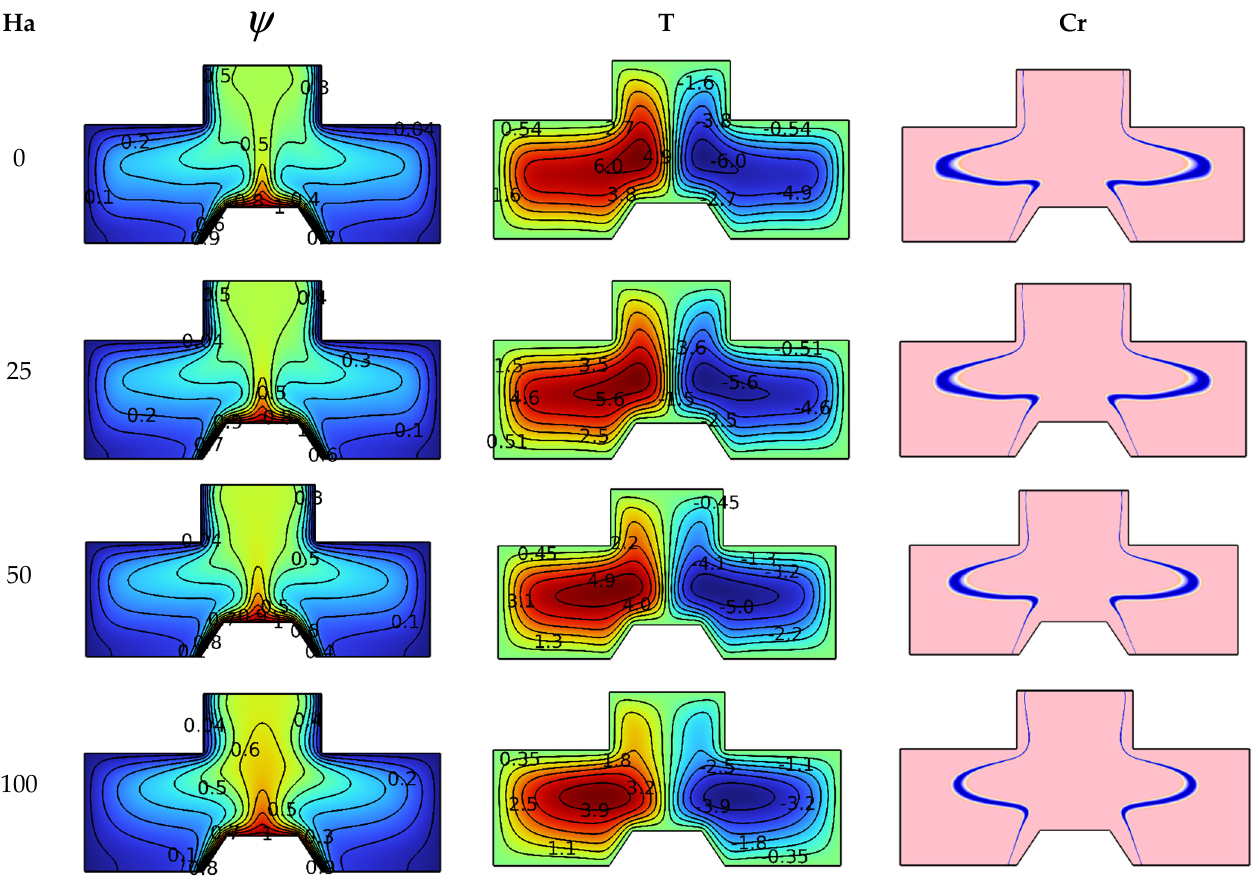
Figure 4. Ha number influence on streamlines, isotherms, and Cr for Ra = 10 5 , Da = 10 − 2 , and φ = ϕ = 4%.